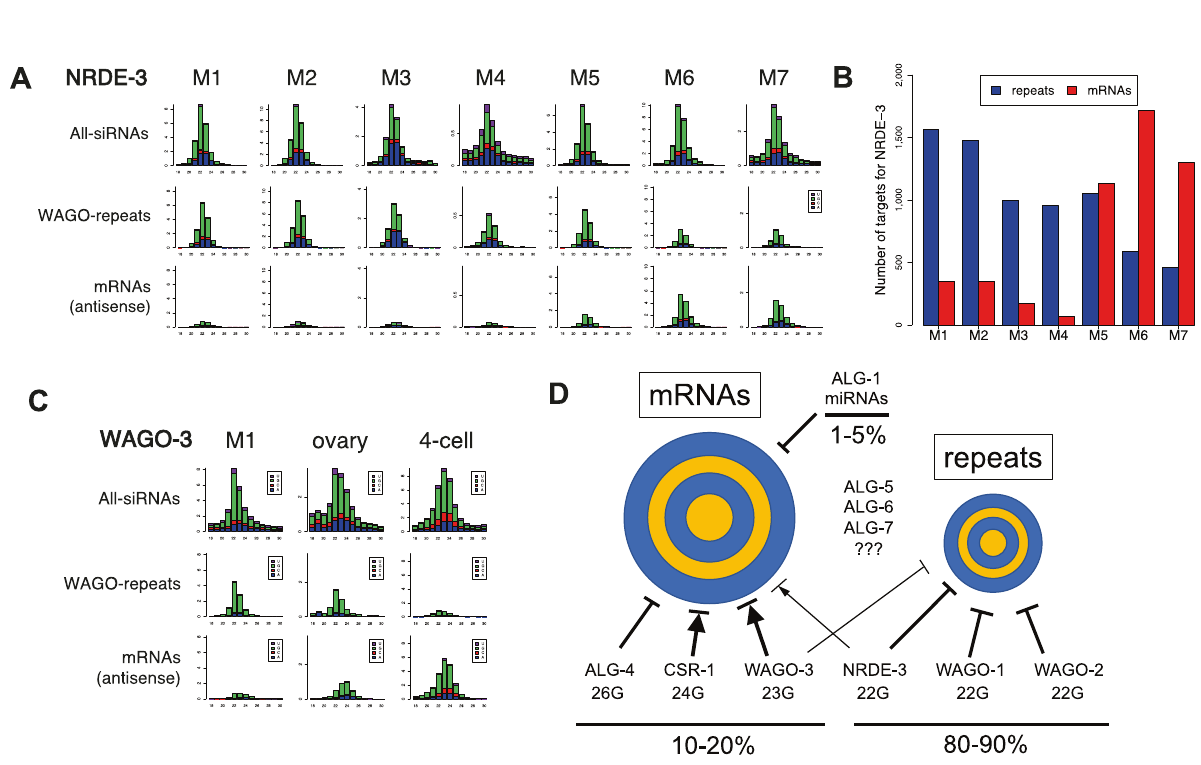
Fig. 7 Plasticity of Ascaris small RNA pathways. A AsNRDE-3 bound small RNAs change their targets from genomic repetitive sequence to mRNAs during spermatogenesis (M5 – M7). B AsNRDE-3 mRNA and repeat target changes by during spermatogenesis. C WAGO-3 bound small RNAs change their targets from genomic repetitive sequence in male mitotic germline to mRNAs in 4-cell embryos. Source data are provided as a Source Data fi le. D Model for Ascaris small RNA pathways (see text). The two concentric circles represent Ascaris mRNAs (left) and repeats (right) targeted by small RNAs. The larger size of the mRNA circle indicates the larger number, complexity, and abundance of the mRNAs compared to the repeats targeted by small RNAs. Overall, however, in terms of abundance of small RNAs, 80 – 90% of all small RNAs target repeats. The 10 Ascaris Argonautes and their known associated major small RNAs (22 G, 23 G, 24 G, 26 G, and miRNAs) are shown. Lines with an arrow indicate licensing or fi ne-tuning ( → ) of expression, a blocking line indicates repression ( __ |), and an arrow with a blocking line indicates both licensing/tuning and repression ( → |). Bolder lines indicate predicted stronger affects. Note several Ascaris Argonautes (CSR-1, WAGO-3, and NRDE-3) could be involved in both licensing and repression of their mRNA targets. In addition, NRDE-3 and WAGO-3 can target both mRNAs and repeats and their targets change through development, illustrating the plasticity of small RNA pathway in Ascaris protein genes, sperm motility genes, sperm-speci fi c family genes, spermatid formation, as the timing of these 26G-RNAs expres- class P genes, and pp1 phosphatases are also targeted by sions (M6 – 7) is in general later than their targeted mRNAs C. elegans ALG-3/4 31,72 indicating conservation of 26G-RNA (M5 – 7), including AsALG-4 mRNA itself (Supplementary Fig. 9). targets. However, many of the Ascaris 26G-RNA targets are unknown hypothetical genes and generally not conserved in other nematodes. New and novel genes have been shown to evolve at high levels in the testis 83 – 85 . The expression of these genes may require concerted control. AsALG-4 and its associated 26G-RNAs likely play a major role in clearing late meiosis mRNAs during